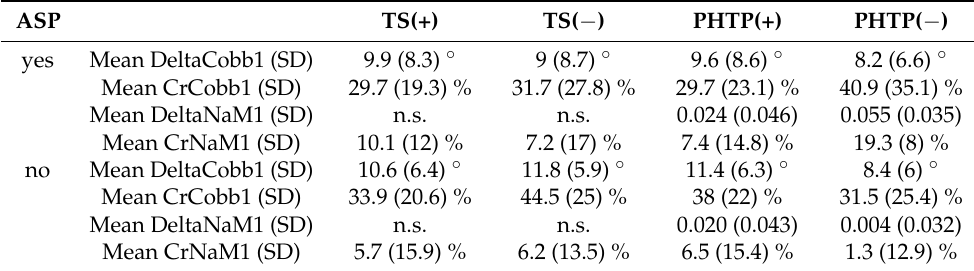
Table 5. Combined brace parameter effects on (major)